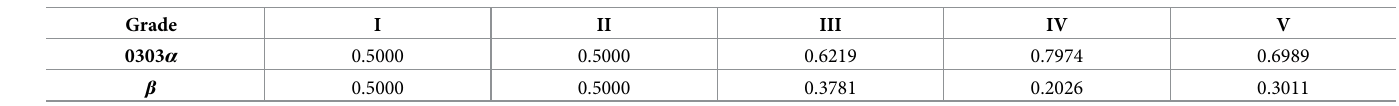
Table 5. Two parameters of